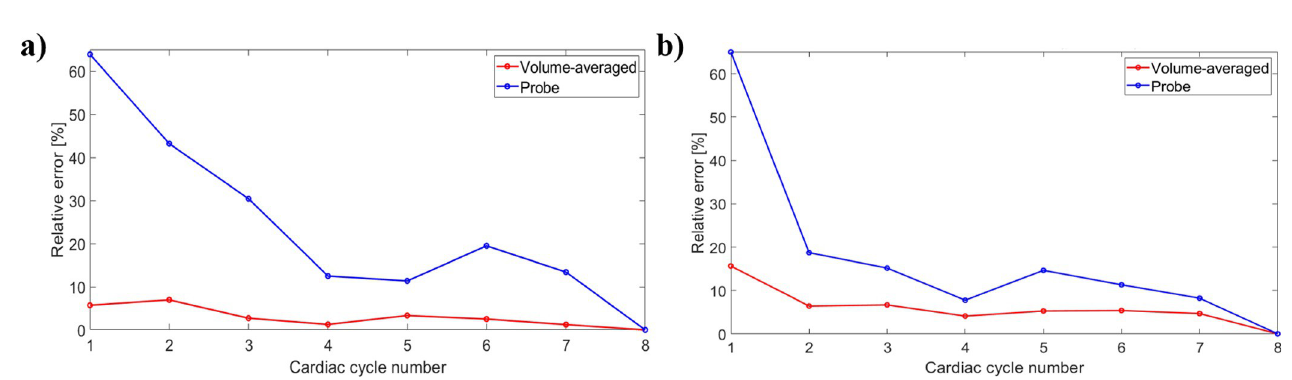
Fig 8. Relative percentage error for velocity (a) and pressure (b) measurements with increasing number of cardiac cycles.